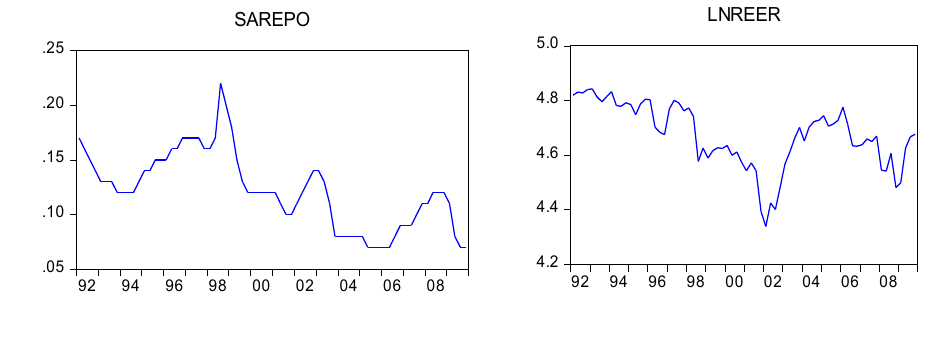
TABLE A1: Unit root tests Variables ADF PP DF-GLS KPSS Botswana Log of Real